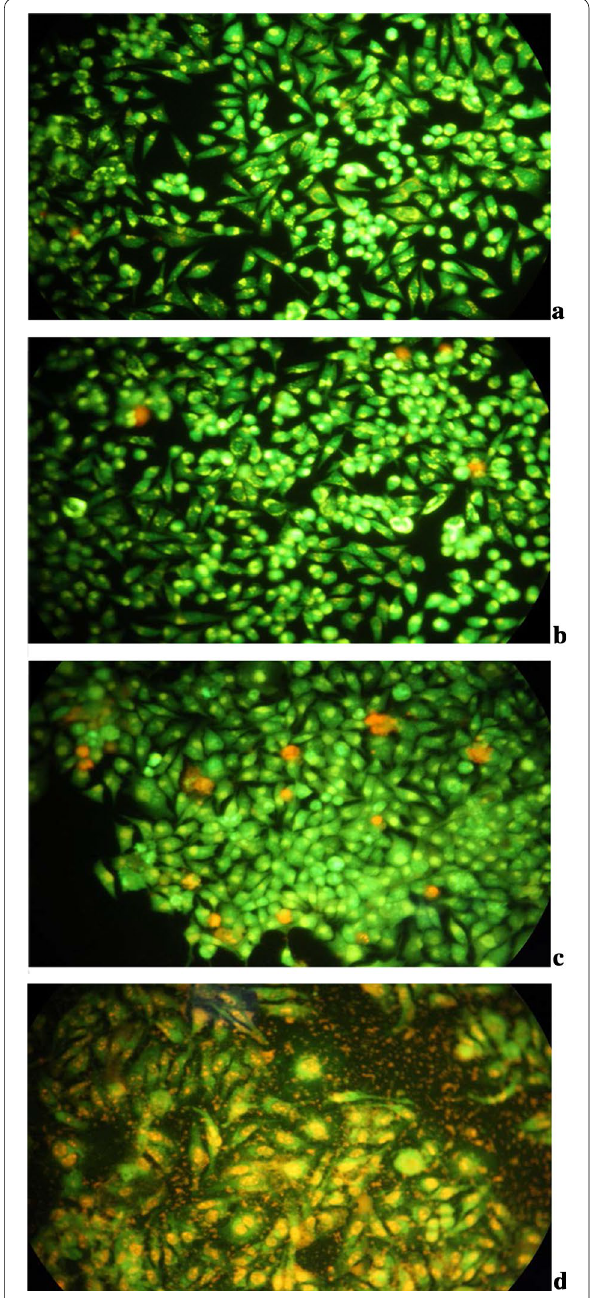
Fig. 12 The AO/EB of control ( a ), Tau-GO ( b ), 5-FU ( c ), and 5-FU-Tau-GO ( d )